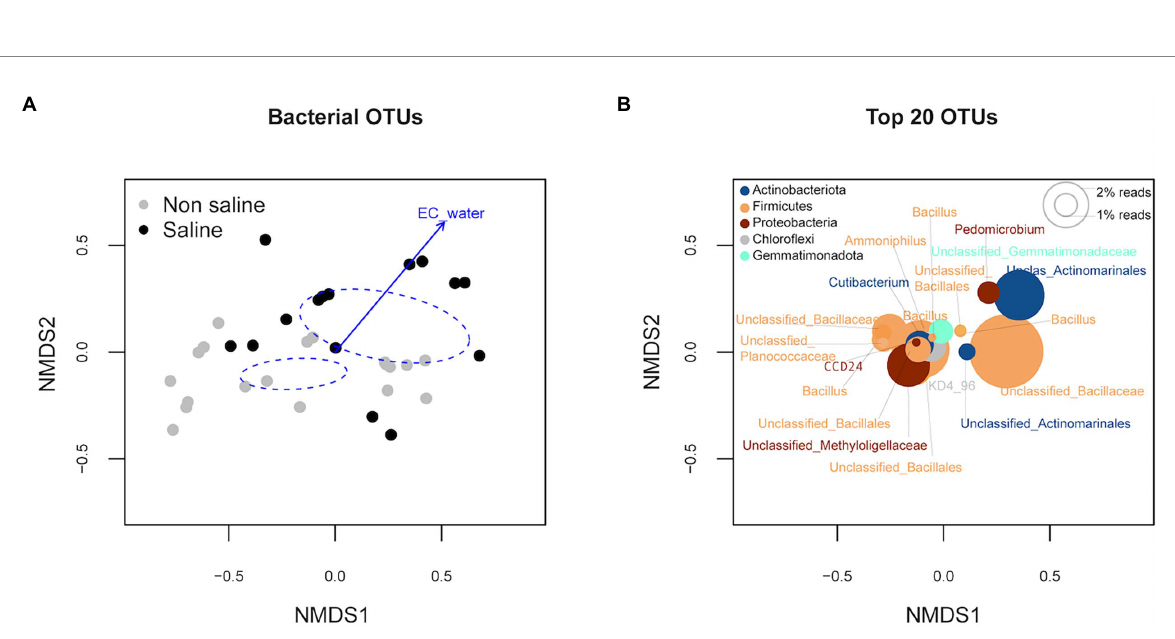
FIGURE 3 Multivariate non-metric multidimensional scaling (NMDS) ordination analysis of bacterial communities in soil under non-saline water and saline groundwater irrigation. (A) The ordination plot was generated based on the operational taxonomic unit (OTU) abundance of soil under non-saline and saline groundwater irrigation. The colors are coded according to (A) the irrigation water source (non-saline vs. saline groundwater irrigation) and (B) bacterial phyla. The 95% ellipse represents the confidence interval for the tested factor variable (i.e., irrigation water source) and direction and length point increased influence of the significant variable ( p < 0.05) on the bacterial communities of samples in the pointing direction of ordination configuration. (B) Species plots of the top 20 bacterial taxa based on total OTU composition. The size of the circles indicates the relative abundance of the